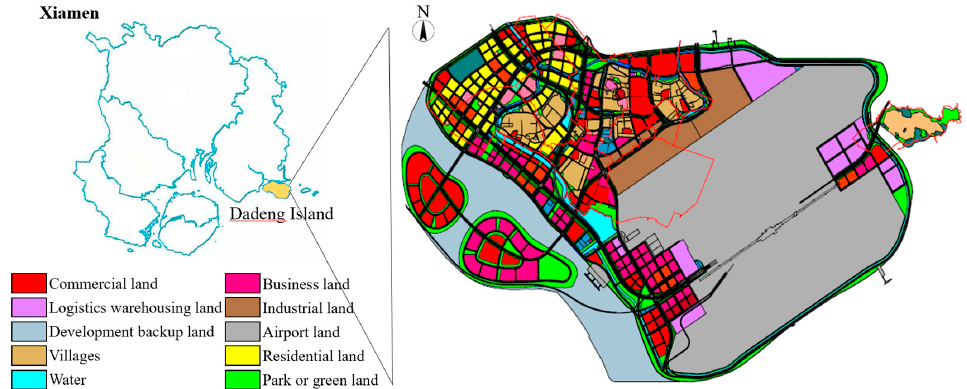
Figure 1. The location and land-use type of the study area.